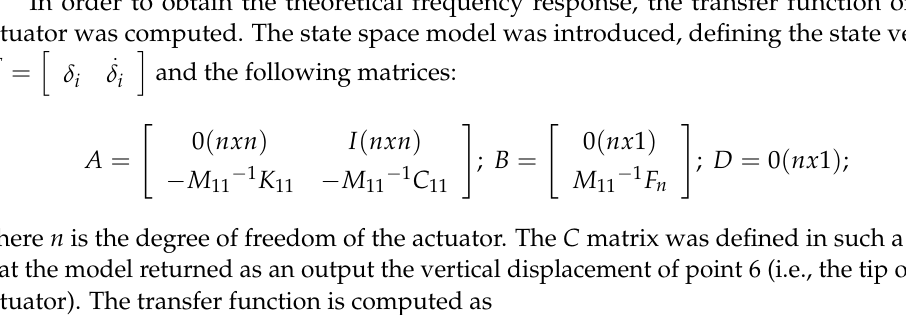
Figure 5. Closed-loop system. The filtered PID controller acted by minimizing the error function (cid:1857)((cid:1872)) = (cid:2009) (cid:3045)(cid:3032)(cid:3033) ((cid:1872)) − (cid:2009)((cid:1872)) , being (cid:2009) (cid:3045)(cid:3032)(cid:3033) ((cid:1872)) = 0 (cid:1870)(cid:1853)(cid:1856) , because the aim was to stabilize the system. The reference signal sent to the actuator was the voltage input, and it was computed as the sum of three terms: one proportional to the current error, one proportional to the time integral of the error, ensuring the system reached the desired setpoint, and the last term proportional to the filtered error time derivative [30]: Δ(cid:1848)((cid:1872)) = (cid:1837) (cid:3043) (cid:4680)(cid:1857)((cid:1872)) + 1 (cid:2028) (cid:3036) (cid:3505) (cid:1857)((cid:2028))(cid:1856)(cid:2028) (cid:3047) (cid:2868) + (cid:1857) (cid:3005) ((cid:1872))(cid:4681)